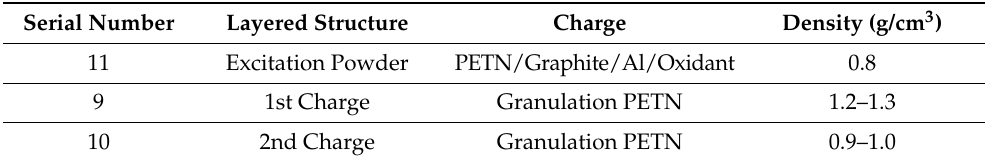
Table 1. Initiating equipment (End A and End B). Types of Initiating Equipment Table 2. Layered structure ’s charge densities.